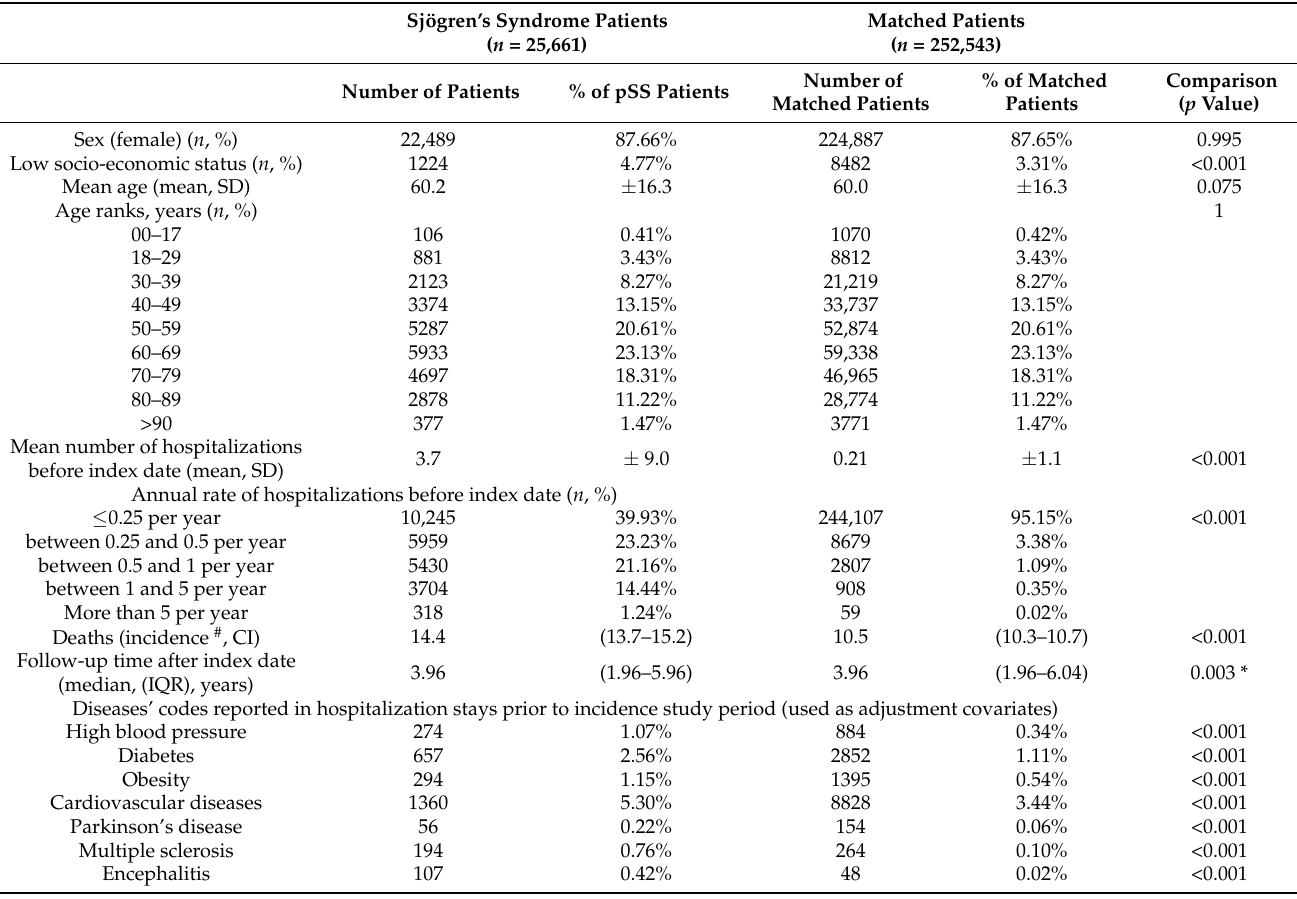
Table 1. Demographic and social characteristics of hospitalized primary Sjögren’s syndrome patients and their matched controls and adjustment